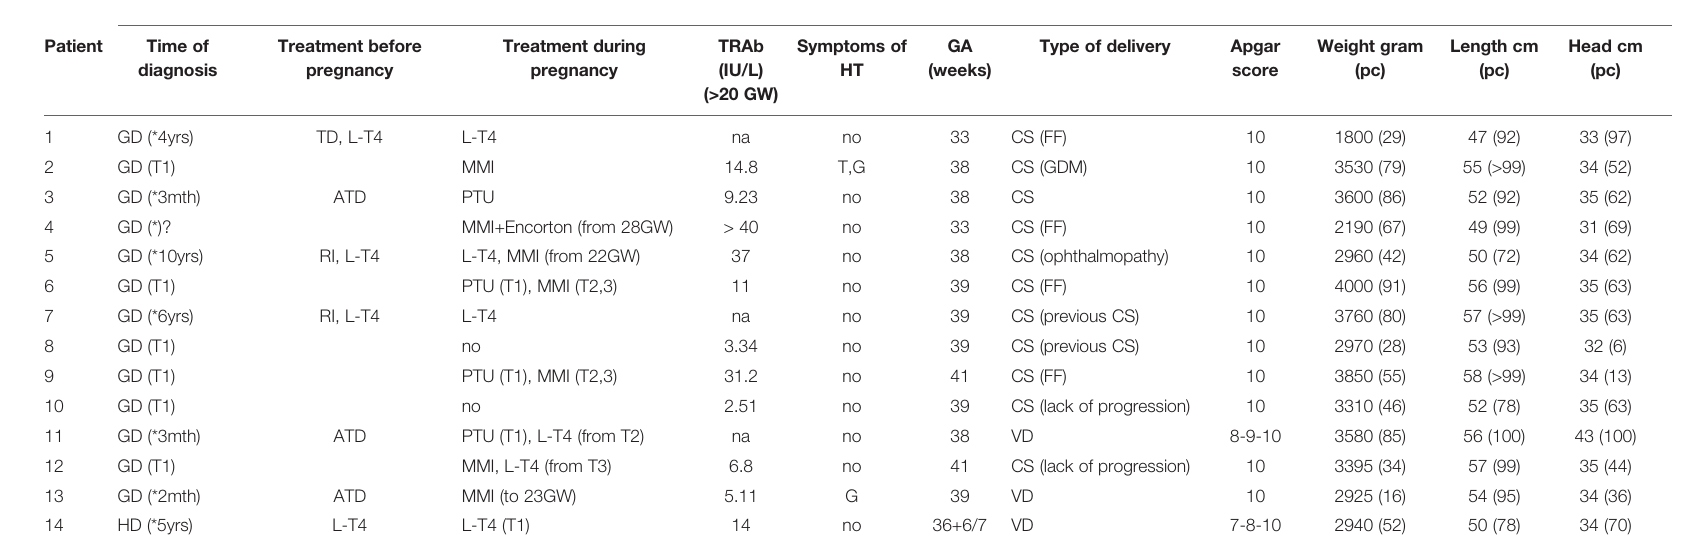
TABLE 1 | The maternal, fetal and neonatal